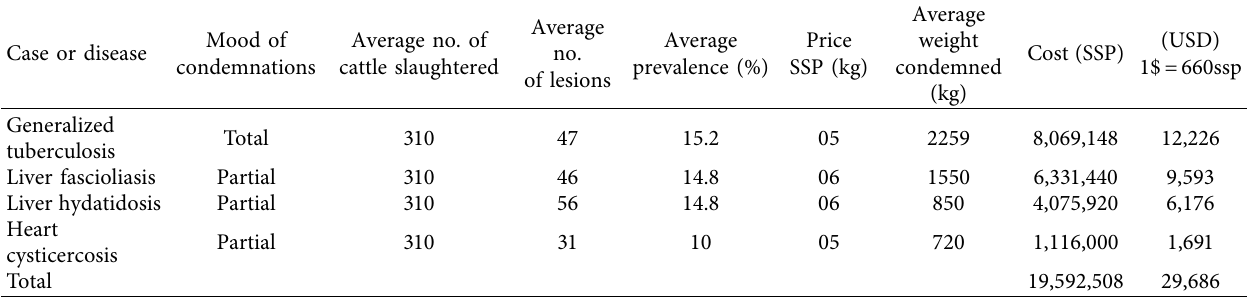
Table 2: Cases and fnancial loss from cattle total and partial condemnation in Wau abattoir. Case or